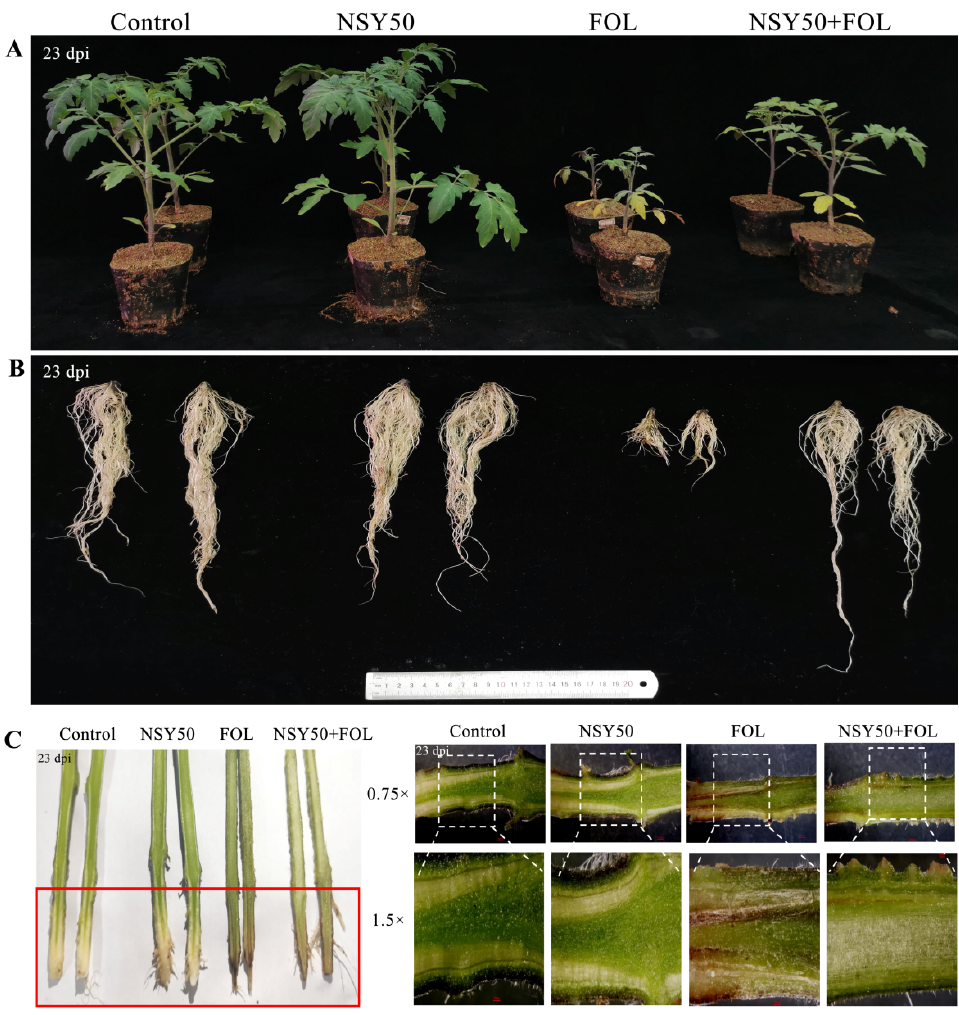
Figure 1. Effect of P. polymyxa NSY50 on phenotype of AC seedlings infected with Fol . ( A ) Plant phenotypic symptoms on the 23rd day after Fol inoculation; ( B ) root tissue of tomato plants on 23 dpi of different treatment; ( C ) longitudinal section of tomato plant stem.